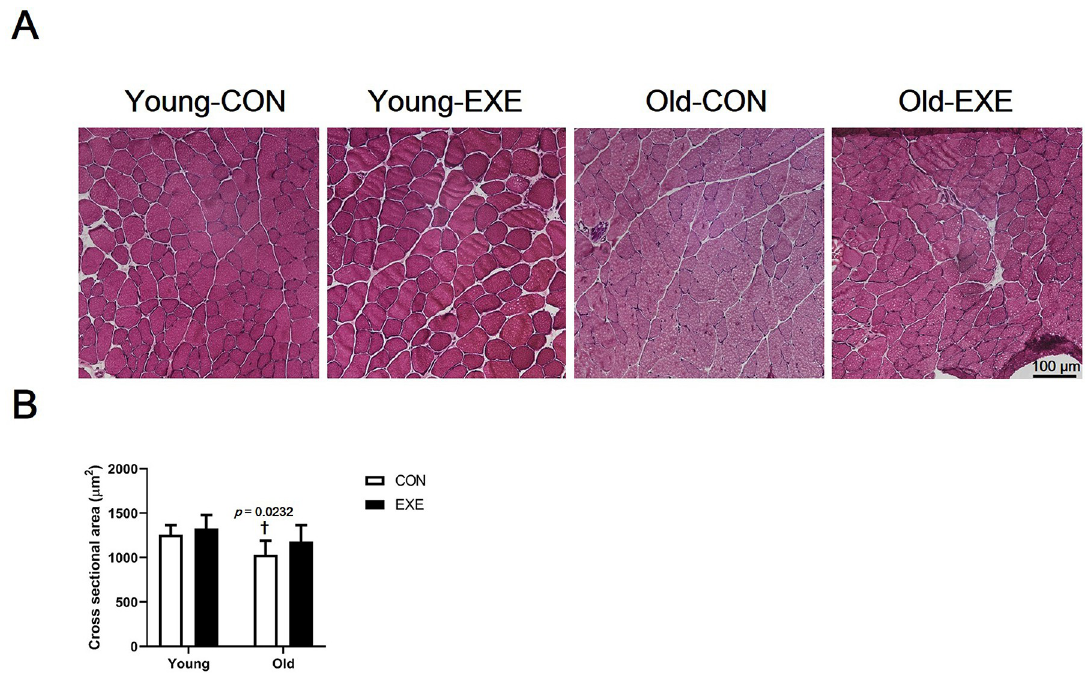
Fig 3. Difference in fiber-cross sectional area (CSA) of skeletal muscles of experimental mice subjected to LSE. (A) Skeletal muscle tissue microscope slides stained with Hematoxylin & Eosin. (B) Comparison of skeletal muscle fiber CSA between groups. All data are presented as the mean ± SD vs. control group of different age, † p < 0.05.